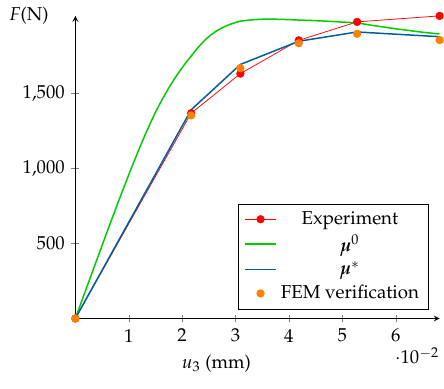
Figure 12. Result of the H 2 ROM